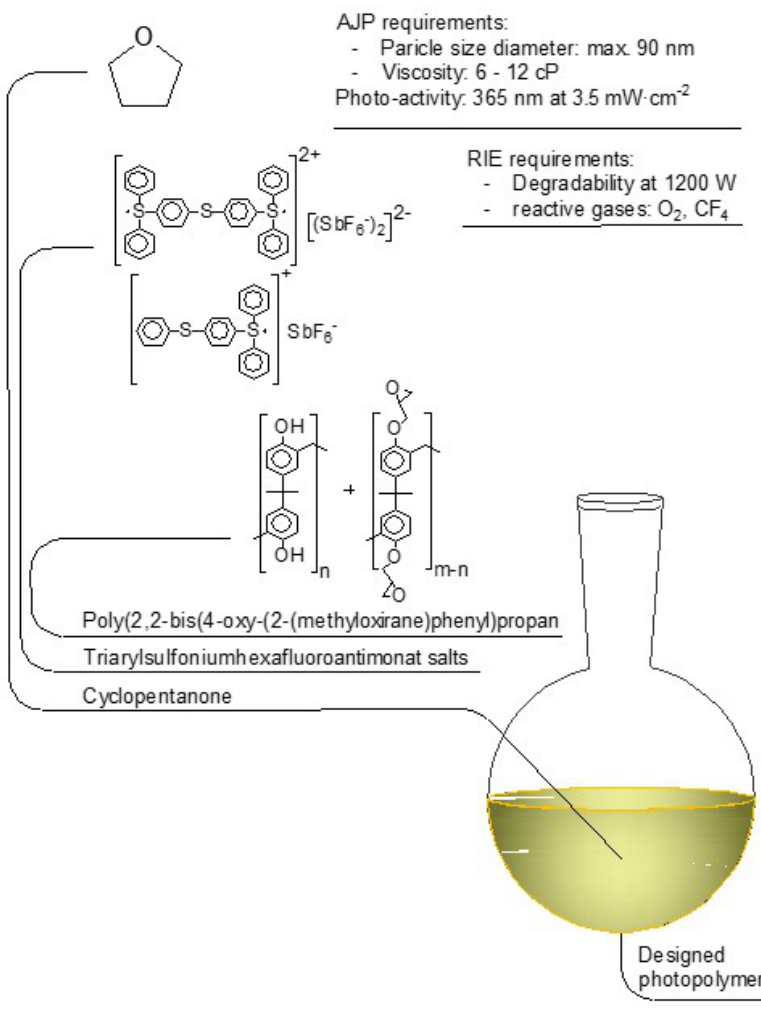
Figure 4. Photopolymer formulation. Aryl epoxy oligomer, TAS, and cyclopentantone chemical structures. AJP and RIE requirements for ink